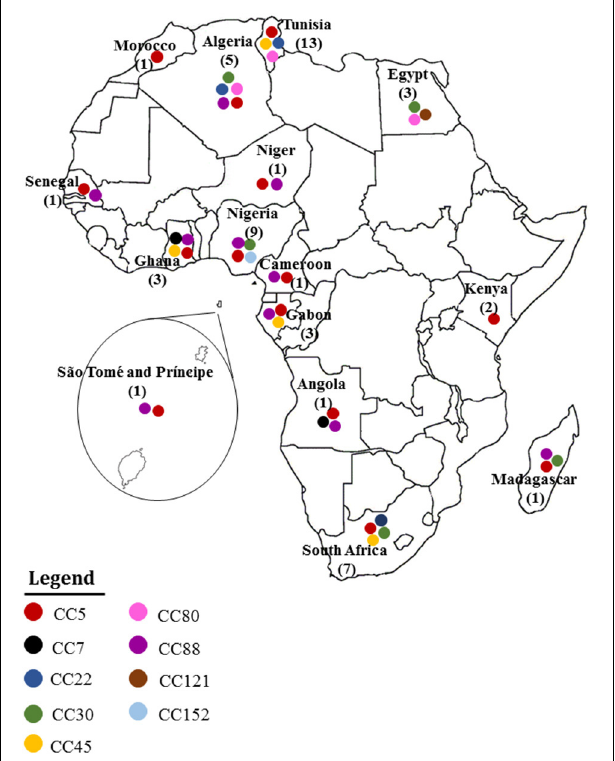
FIGURE 2 | MRSA clones reported in Africa. Each clonal complex is annotated with a colored circle. The number of studies conducted in each country is also